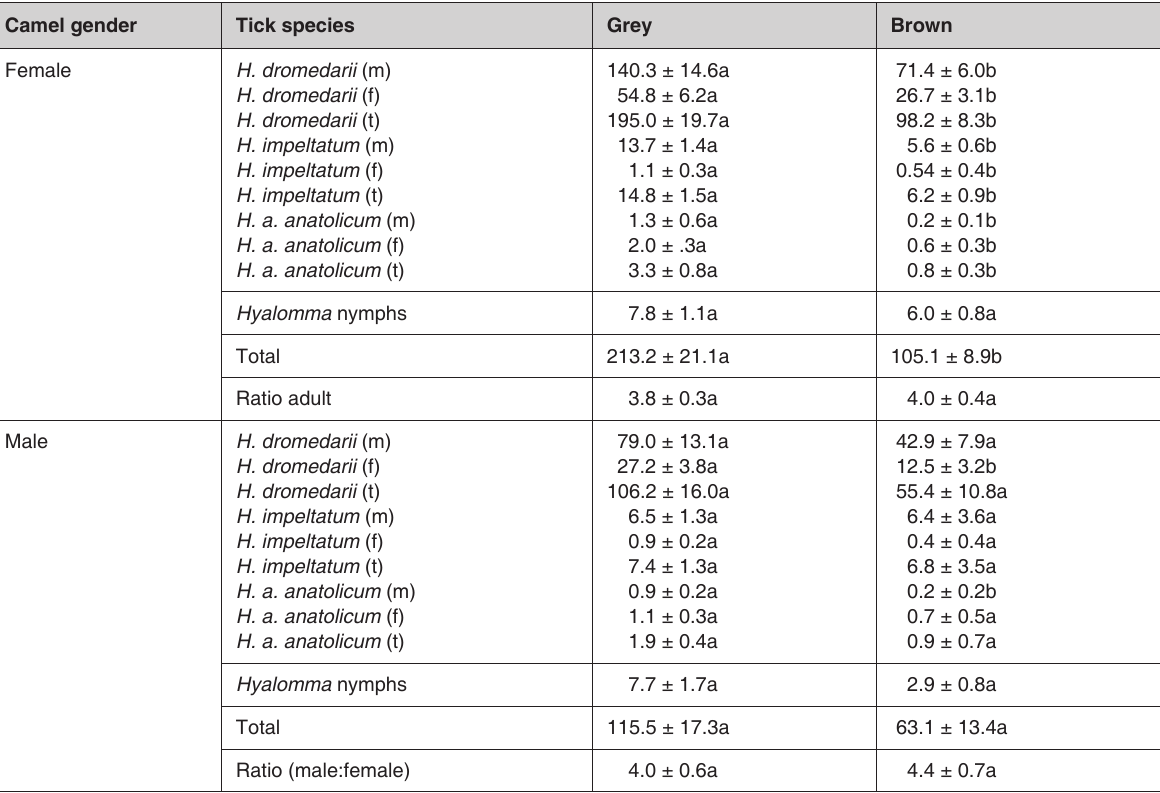
TABLE 7 Mean (± SE) number of ticks collected from male and female camels of different coat colour in River Nile State in 2000 and 2001 Camel gender